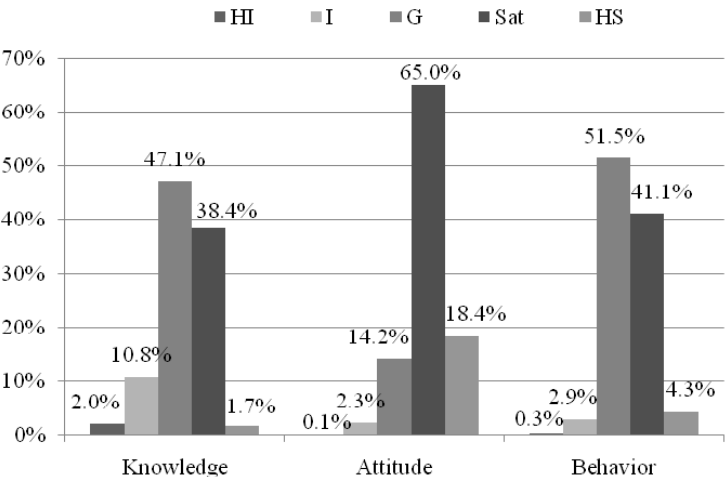
Figure 1. Distribution of eating out related KAB ( n = 1634). HI, highly insufficient ( ≤ 20% of total score); I, insufficient (21%–40% of total score); G, general (41%–60% of total score); Sat, satisfactory (61%–80% of total score); HS, highly satisfactory (>80% of total score).For knowledge: N HI = 33; N I = 176; N G = 769;